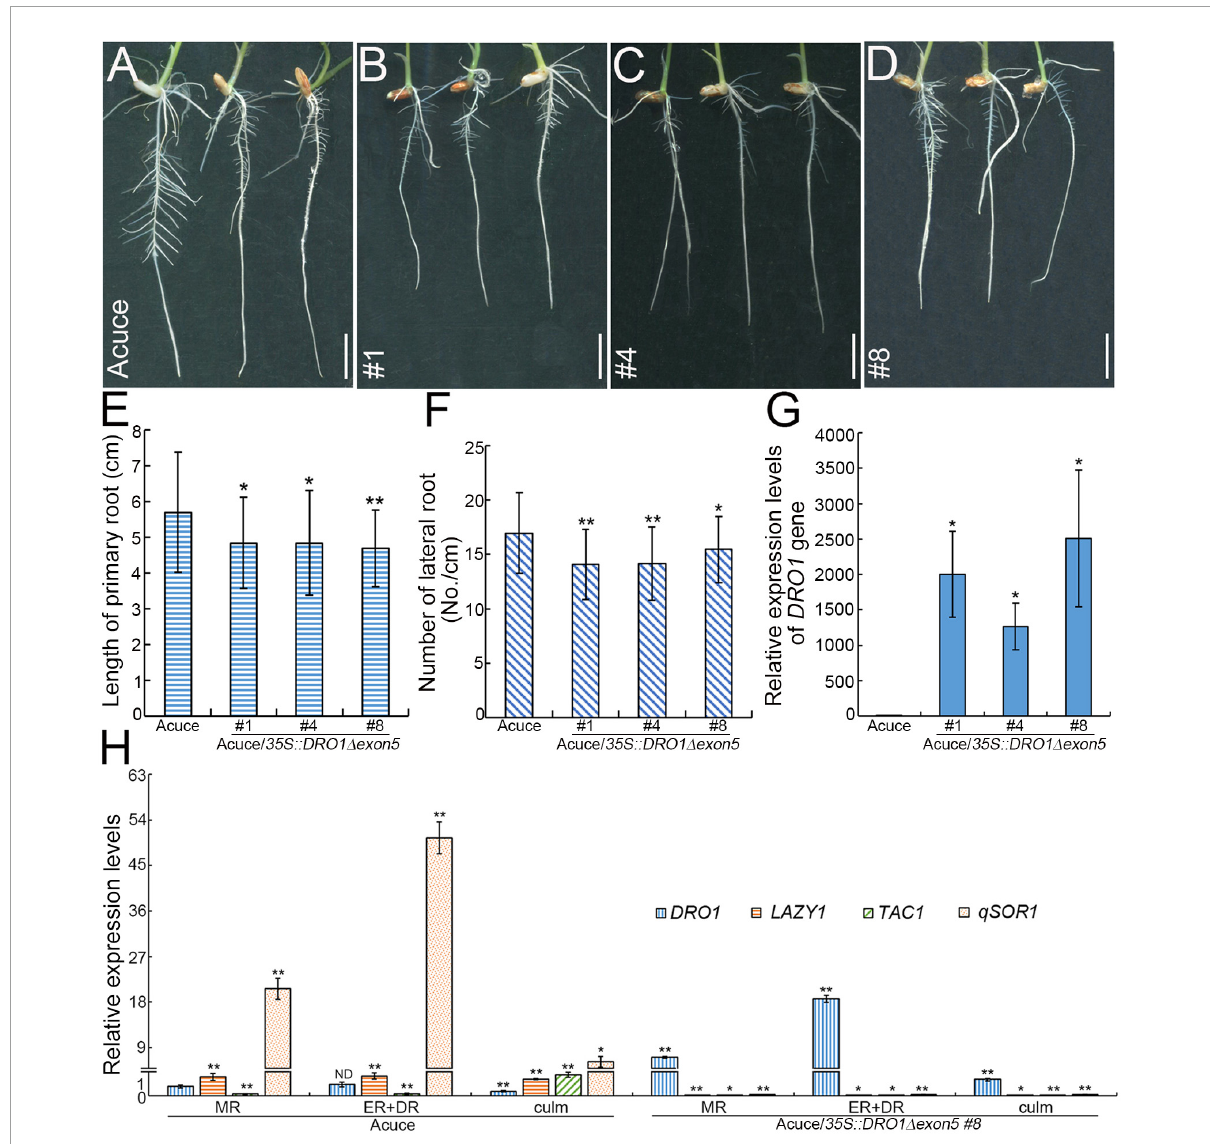
FIGURE6 Root phenotypes of transgenic Acuce rice lines. Root phenotypes of wild-type Acuce (A) and transgenic rice lines (#1, #4, and #8) overexpressing DRO1 with a deletion of the fifth exon (B–D) grown on 1/2 MS medium. Quantification of the primary root lengths (E) ( n Acuce = 43, n Acuce / 35 S : DRO 1 (cid:49) exon 5#1 = 33, n Acuce / 35 S : DRO 1 (cid:49) exon 5#4 = 35, n Acuce / 35 S : DRO 1 (cid:49) exon 5#8 = 39), lateral roots (F) ( n Acuce = 57, n Acuce / 35 S : DRO 1 (cid:49) exon 5#1 = 53, n Acuce / 35 S : DRO 1 (cid:49) exon 5#4 = 56, n Acuce / 35 S : DRO 1 (cid:49) exon 5#8 = 40) and the expression levels of the DRO1 in rice primary roots (G) . The levels of the DRO1 , LAZY1 , TAC1 , and qSOR1 in the primary root and culm of wild-type and transgenic rice line #8 were determined by real-time PCR (H) . The Actin gene was used as an internal control. Data are means ± SD. * P < 0.05, ** P < 0.01 (Student’s t